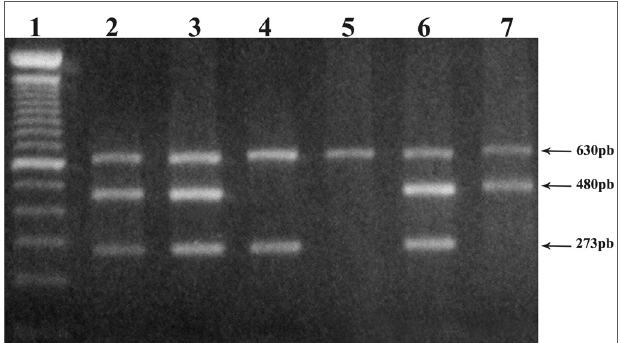
Figura 1. Detecção dos genótipos nulos GSTM1 e GSTT1. Eletroforese em gel de agarose 1,5% demonstrando os produtos de PCR-multiplex de 273bp e 480pb, correspondendo . presença do alelo normal dos genes GSTM1 e GSTT1, respectivamente. O fragmento de 630pb representa o controle interno de amplificação. (1) - marcador de peso molecular (100pb); (2,3,6) - indivíduos com alelos GSTM1 e GSTT1 normais, (4) - indivíduo com alelo nulo para o gene GSTT1, (5) - in- divíduo com alelo nulo combinado para os genes GSTM1 e GSTT1, (7) - indivíduo com alelo nulo para o gene